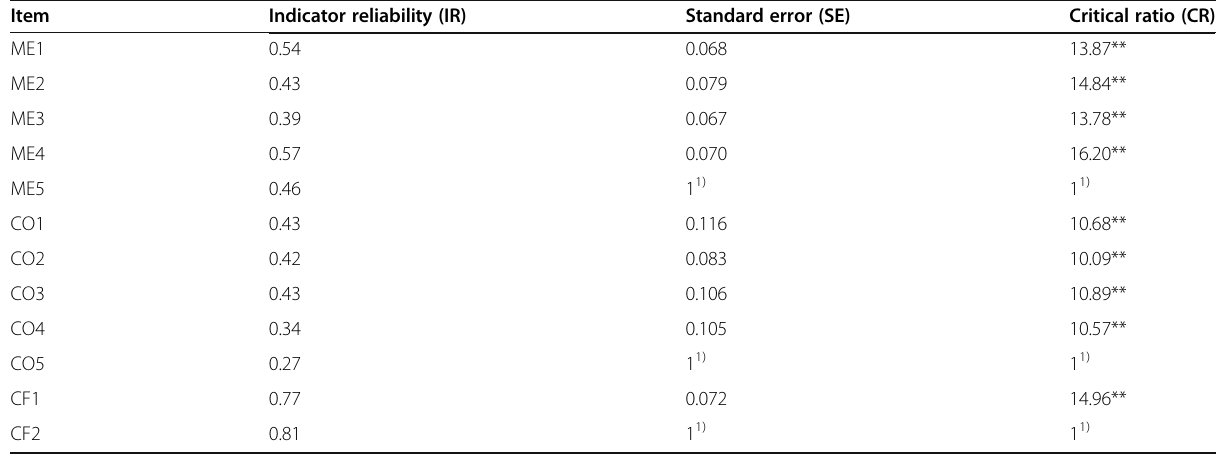
Table 7 Measures of local fit for CFA